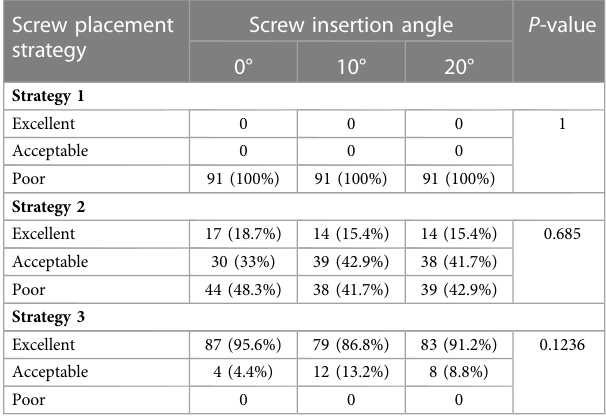
TABLE 1 Evaluation of screw placement strategies. Screw placement